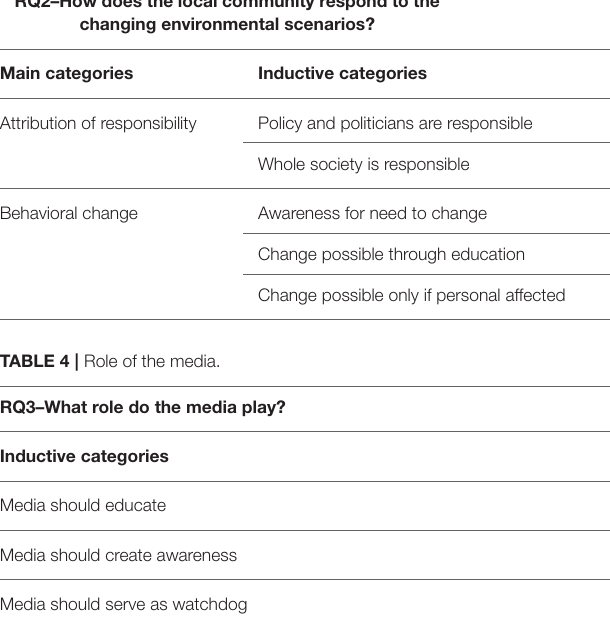
TABLE 3 | Local response to changing environment.